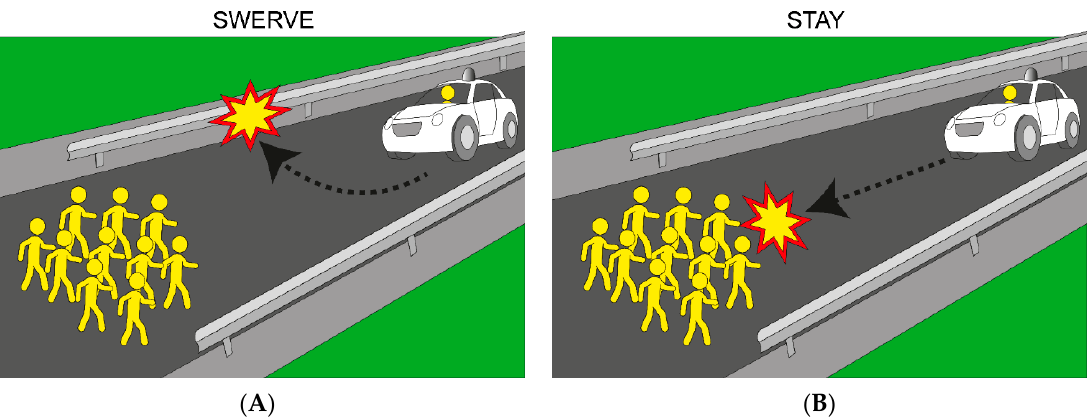
Figure 1. A visual representation of an AV crash scenario. Note. Panel A : a utilitarian AV swerving into a barrier, sacrificing the lone passenger in order to save the 10 pedestrians. Panel B : a non-utilitarian AV staying on its path, sacrificing the 10 pedestrians in order to save the lone passenger.